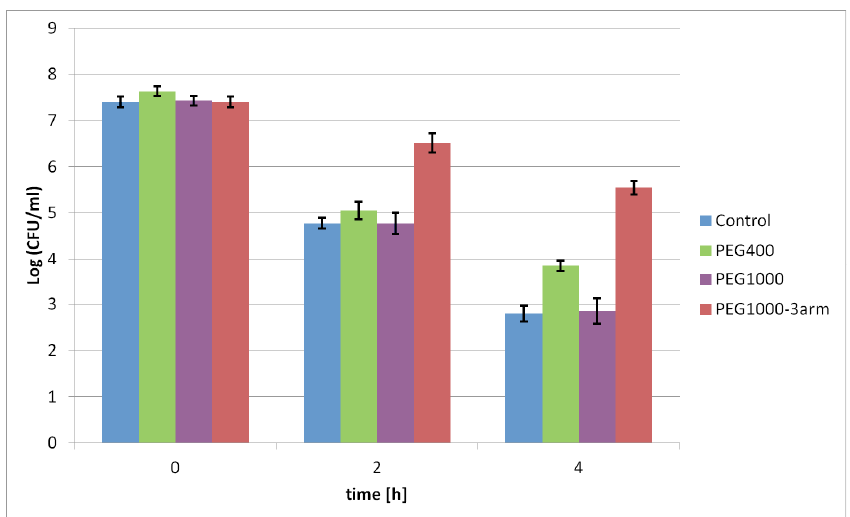
Figure 5. Viability of probiotic bacteria (free cells = control and cells entrapped in γ -PGA-based hydrogels) exposed to pH = 3.0 ( n = 3; error bars, standard deviation).